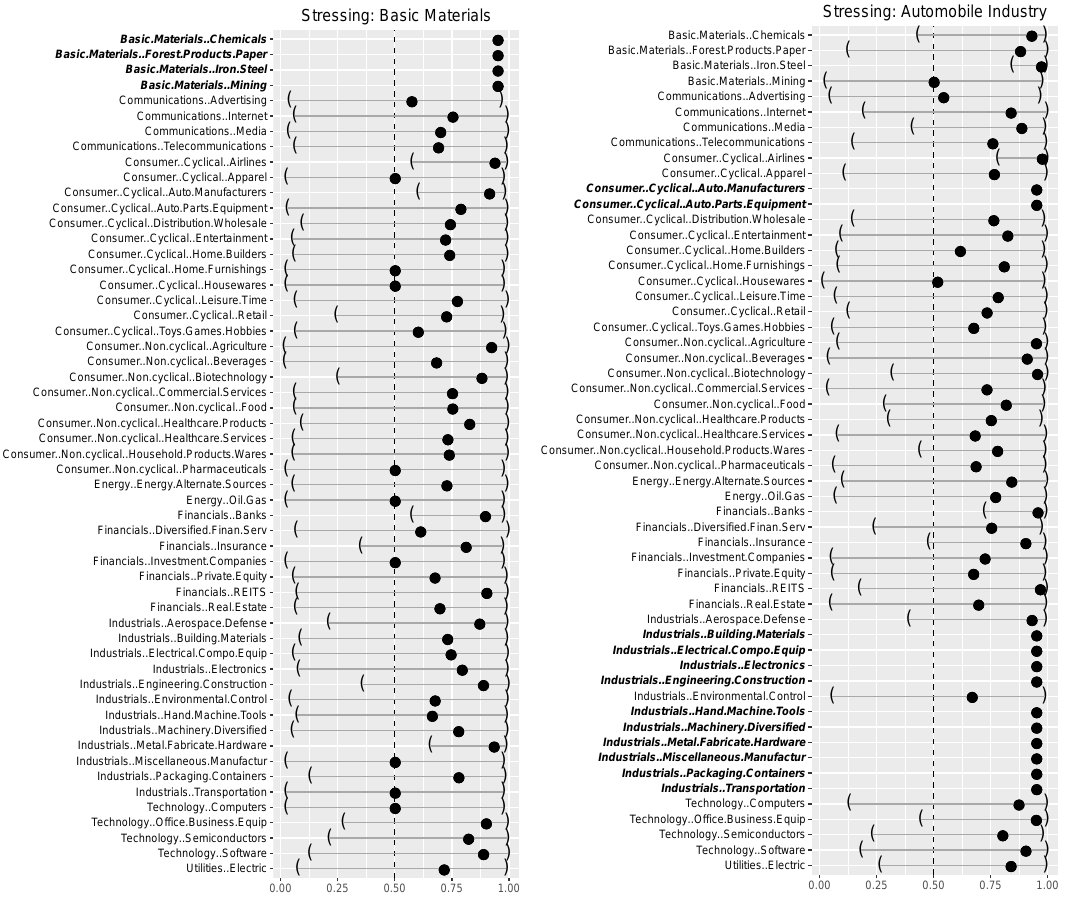
Figure 5. Results of stressing the sub-sectors Basic Materials ( left ) and the Automobile Industry ( right ). The bold italic sub-sectors are stressed at level